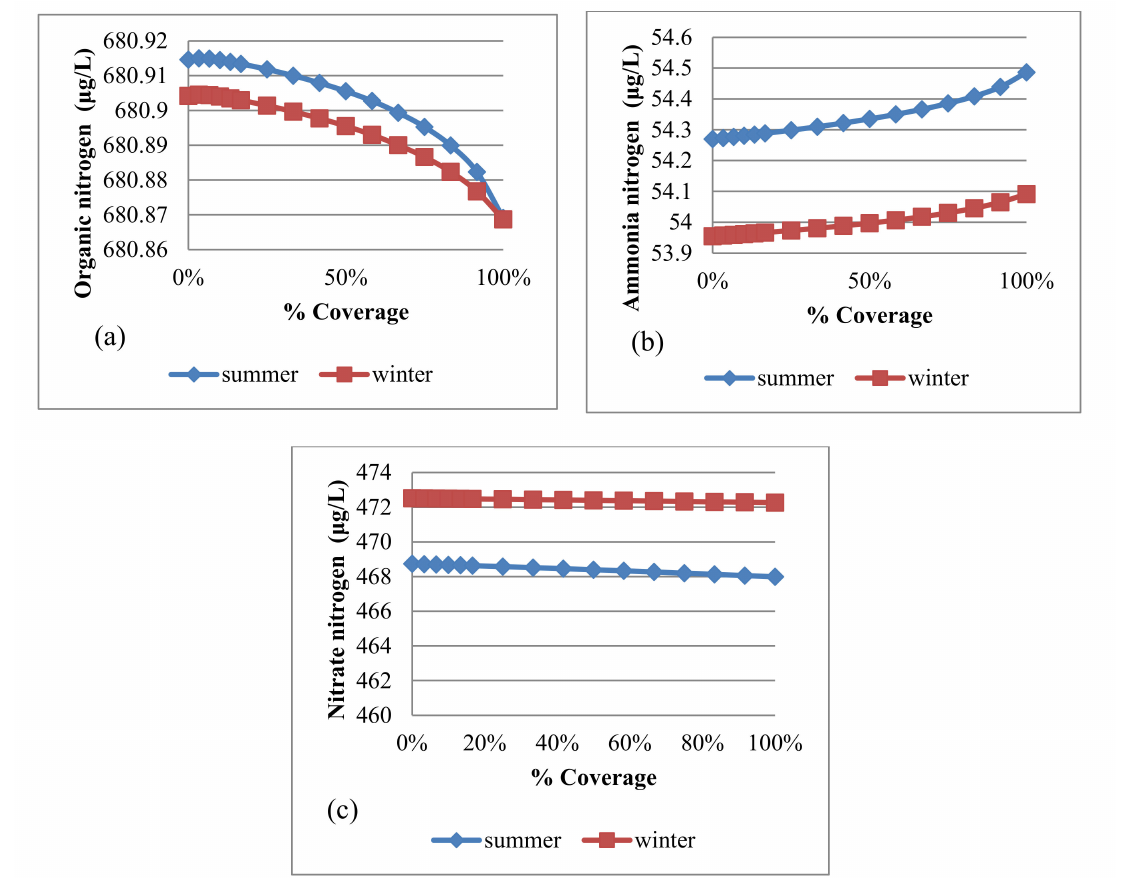
Figure 10. ( a ) The organic nitrogen concentration at the Canal end in the winter and summer vs. percentage coverage for the 50-km length of the Canal, ( b ) the ammonia nitrogen concentration at the Canal end in the winter and summer vs. percentage coverage for the 50-km length of the Canal, and ( c ) the nitrate nitrogen concentrations at the canal end in the winter and summer vs. percentage coverage for the 50-km length of the Canal.